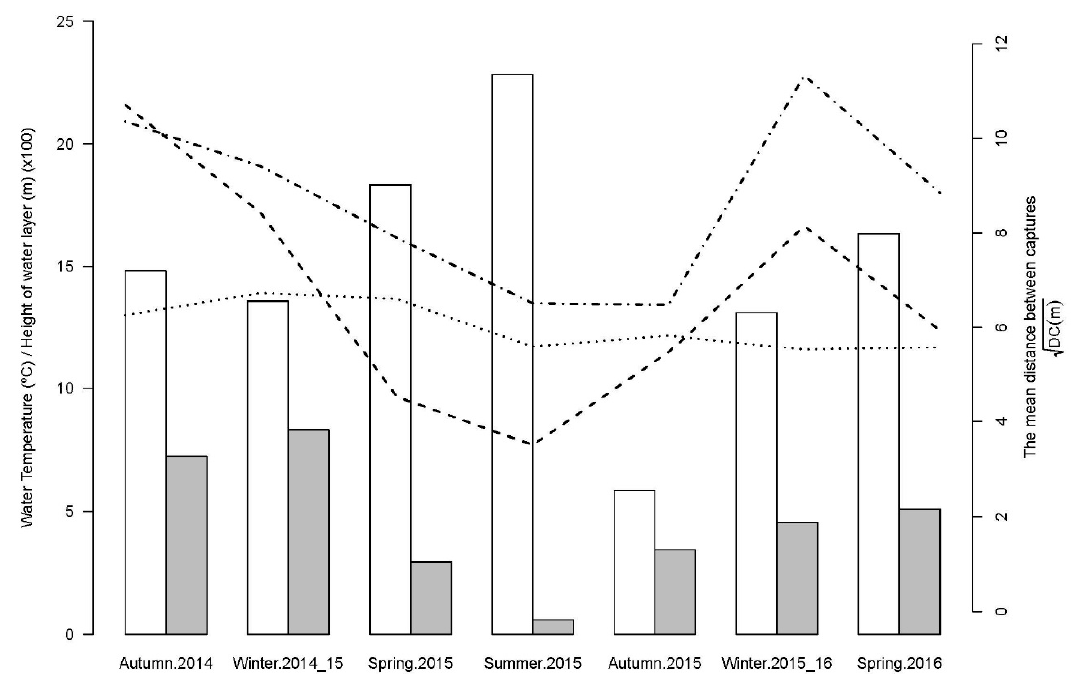
Figure 3. Mean distances moved (square root of DC, observed movements, m) during the study period by length interval in specimens recaptured more than once. Dotted line: eels with TL < 34.9 cm; dashed line: eels with TL between 35–39.9 cm; dot-dash line: eels with TL > 40 cm. Also shown seasonal averages of water temperature ( ◦ C, white bars) and height of water layer ( × 100 m, grey bars).